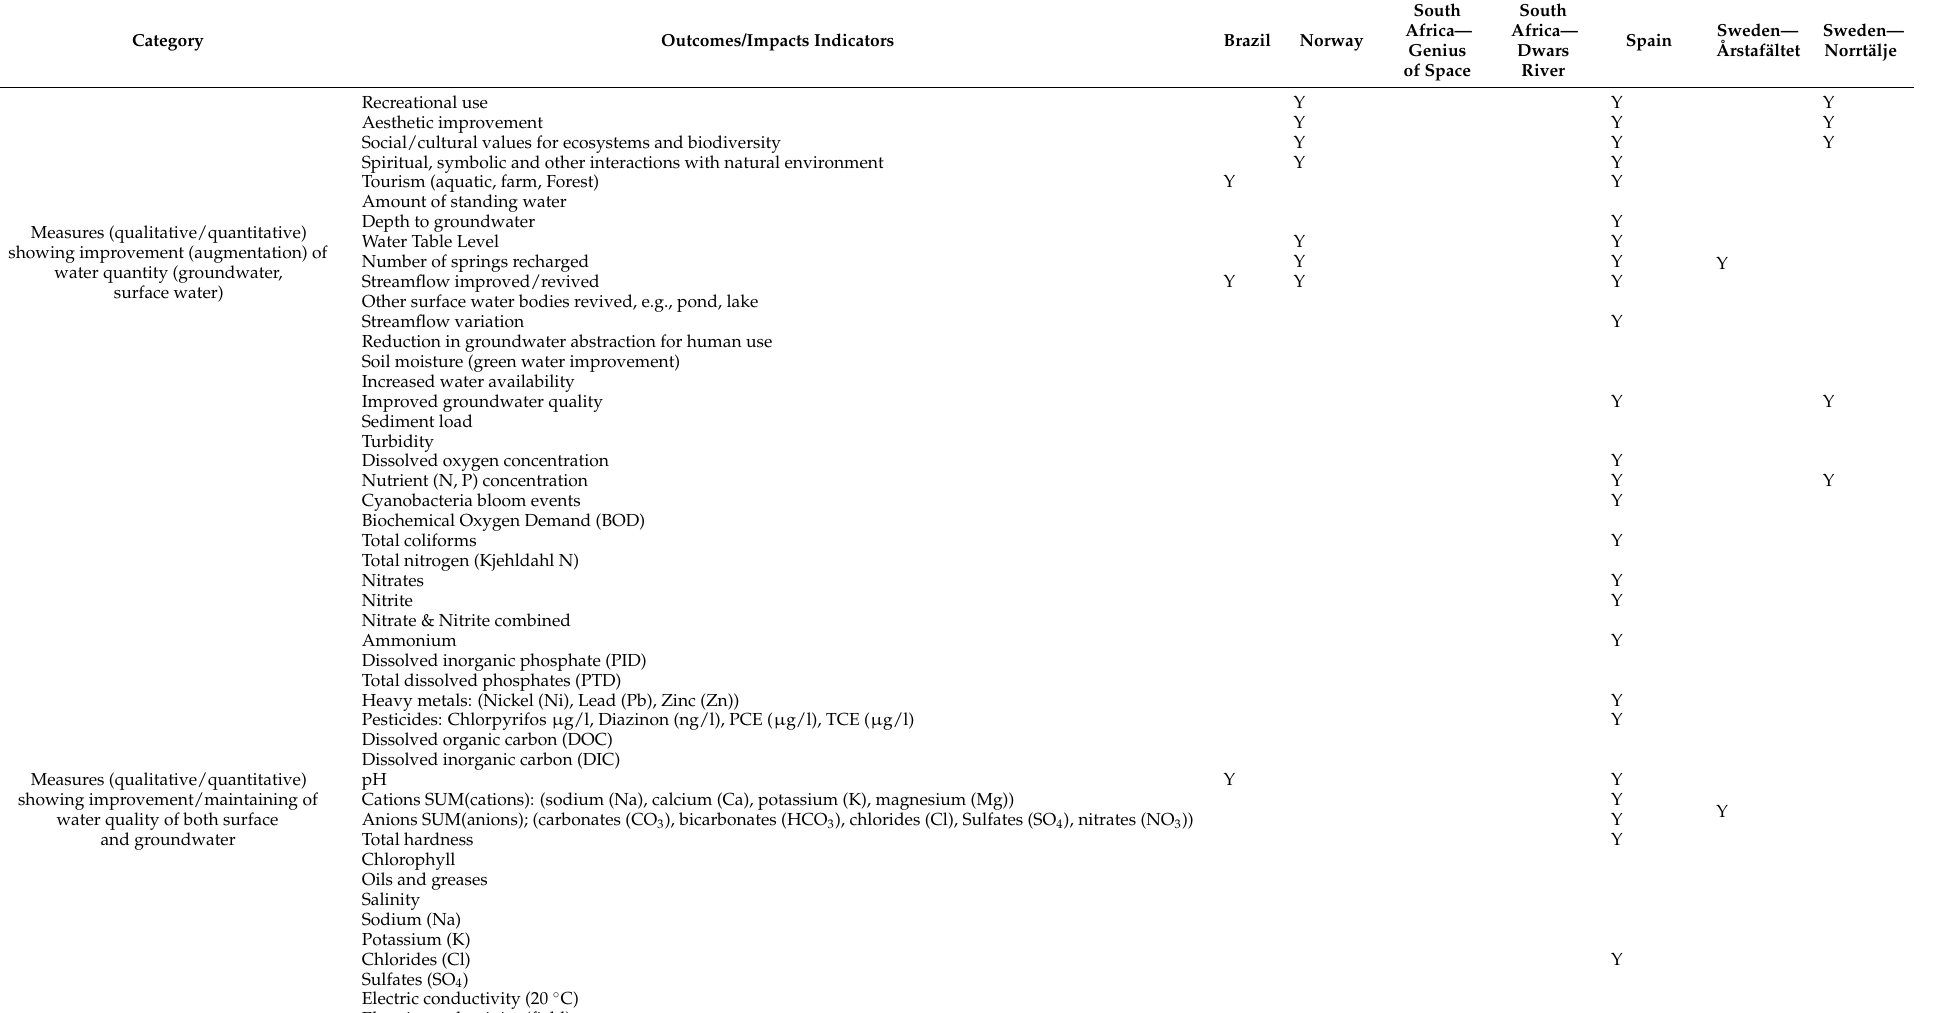
Table 5. Result-based environmental indicators according to whether each case study had data available to assess them (indicated with ‘Y’ for